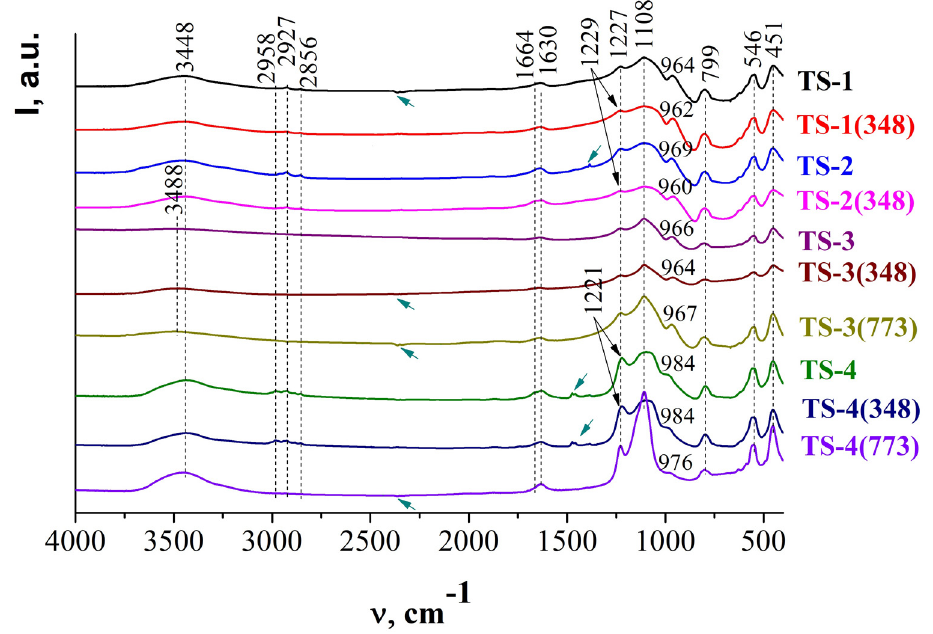
Figure 17. FTIR spectra of TS samples in coordinates Intensity (arbitrary units, a.u.)—absorption frequency (v, cm − 1 ) (black arrows - TS asymmetric stretching vibration; green arrows - organic template (TPAOH) residues groups in zeolite channels) (adapted from [33,34]). Antisymmetric stretching vibrations inside Т O 4 tetrahedra are characterized by the band at ~1108 cm − 1 , which intensity is approximately identical to TS-1 (I 1108cm − 1 = 0.2509 a.u.), TS-3 (I 1108cm − 1 = 0.2438 a.u.), and TS-4 (I 1108cm − 1 = 0.2580 a.u.) and is higher for TS-2